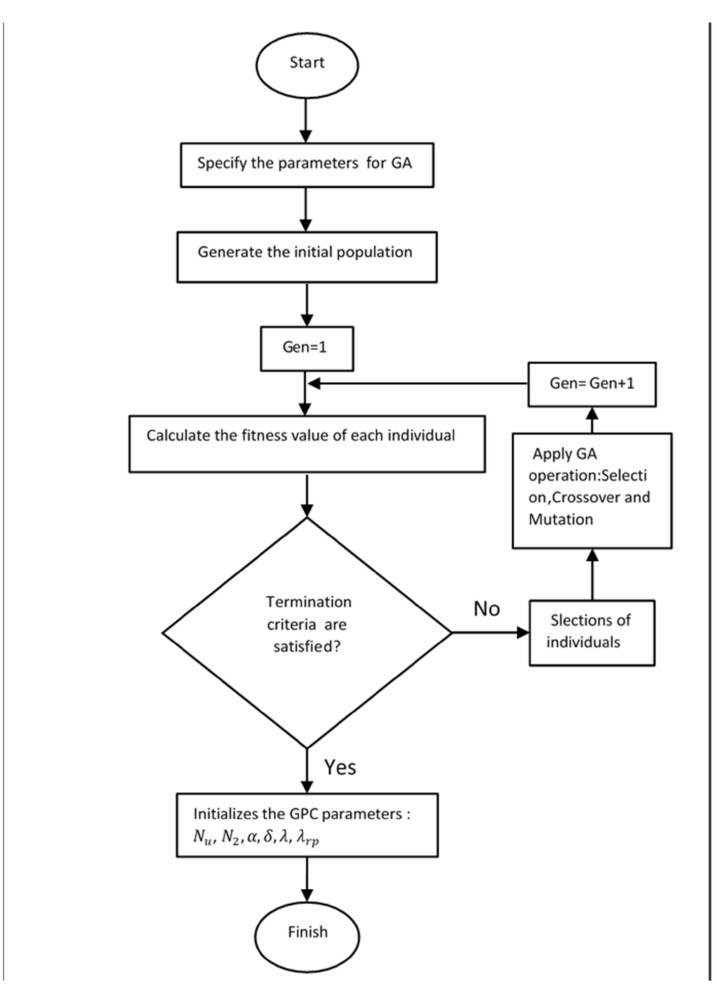
Figure 11. Flowchart of